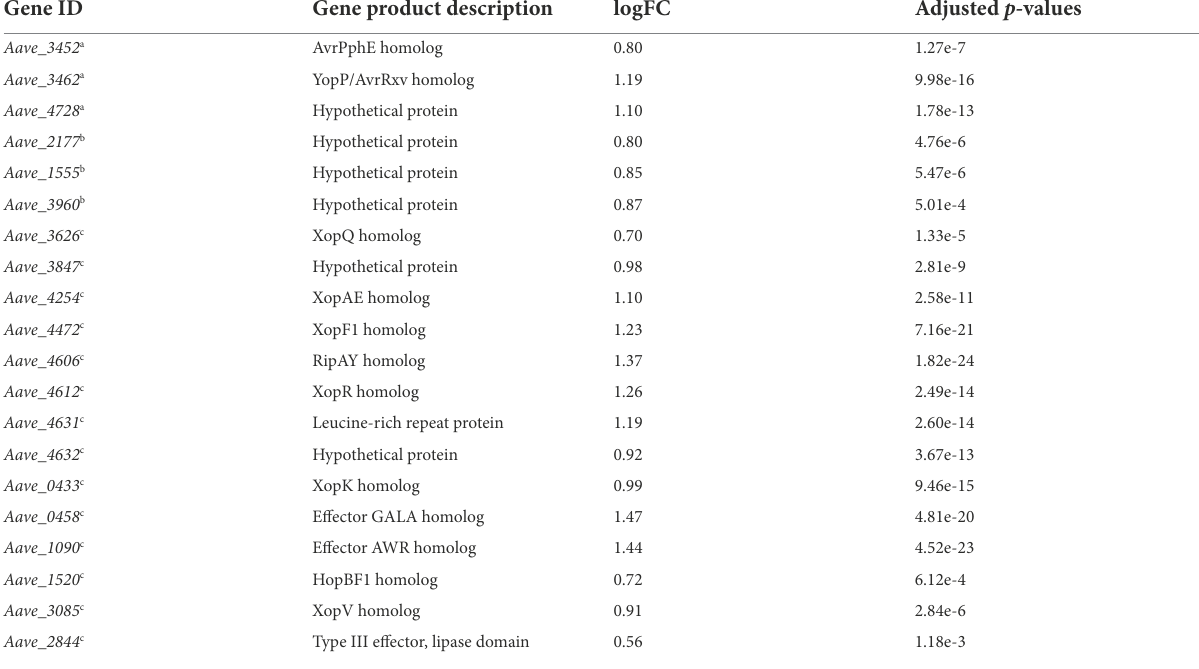
TABLE 4 Differentially expressed type III effector genes in Acidovorax citrulli Δ barA Ac compared to wild-type strain